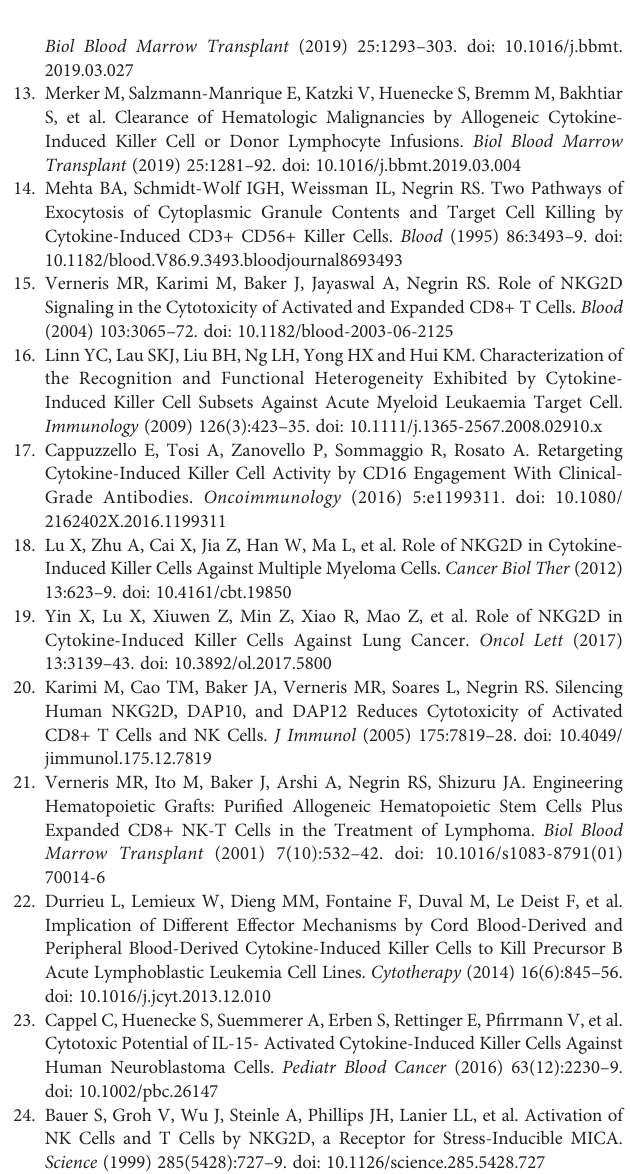
Figure S1 | NKG2D and 2B4 expression on NK cells. NKG2D and 2B4 expression on freshly isolated NK cells from PBMCs were measured by fl ow cytometry after staining with anti-CD3-PerCP-Cy5.5, anti-CD56-FITC, anti- NKG2D-APC and anti-2B4-PE antibodies. Dot plots show the phenotype offreshly isolated lymphocytes (left) and the expression of NKG2D (79.2%) and 2B4 (99.6%) within CD3-CD56+ NK cell population (right). Figure S2 | Costimulation of NKG2D and 2B4 induces strong synergy in degranulation of NK cells. PBMCs were stimulated by indicated plate-bound antibodies(5µg/ml)for5hinthepresenceofanti-CD107a-APCandGolgiStop.Atthe end of culture, cells were stained with anti-CD3-FITC and anti-CD56-PE for selection